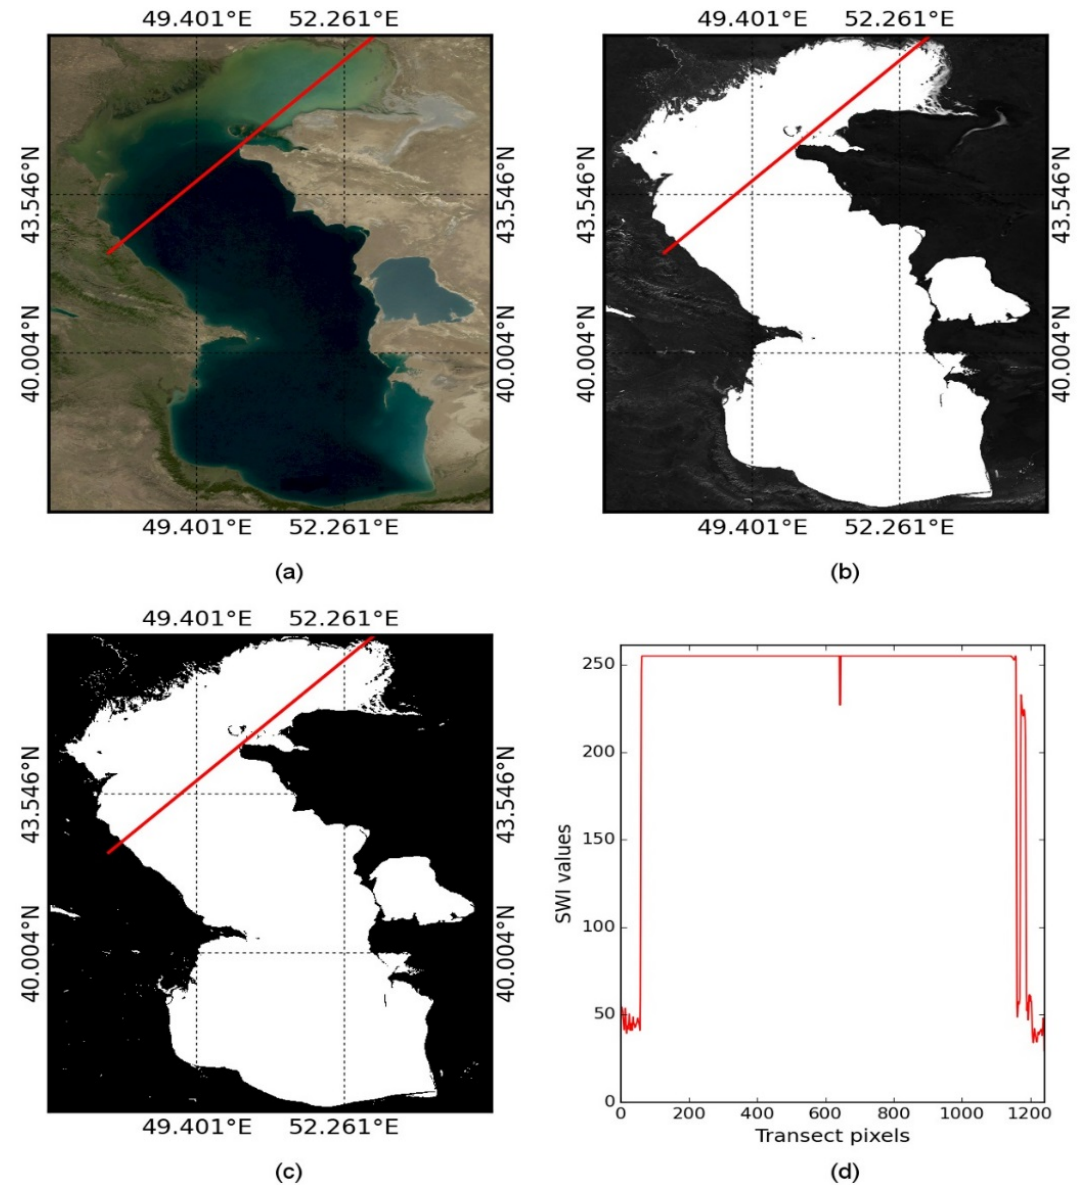
Figure 13. Performance of SWI based extraction of water cover in case of varied turbidity of water bodies: ( a ) MODIS true-color image, ( b ) SWI image, ( c ) Extracted water cover, ( d ) Profile plot of SWI along the red line